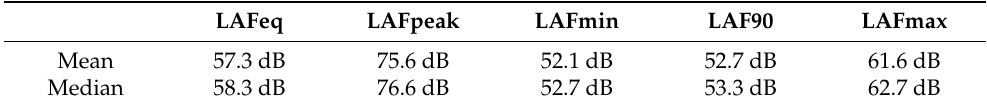
Table 2. Sound levels during the 6-week period. LAFeq LAFpeak LAFmin